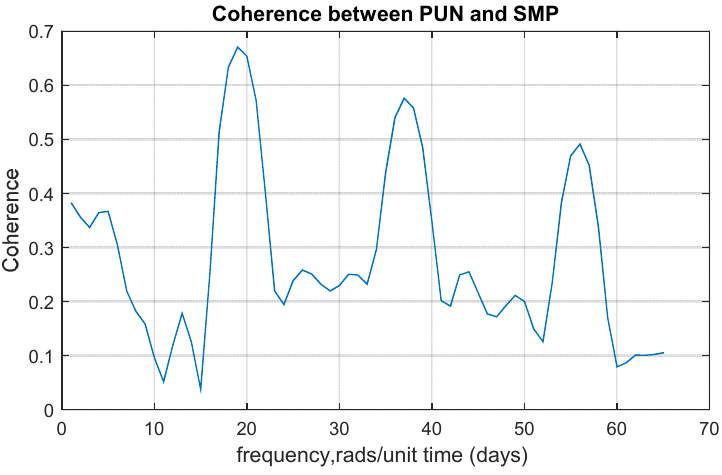
Figure 16. Coherence plot between the SMP and PUN daily series, after applying relation Equation (13), Section